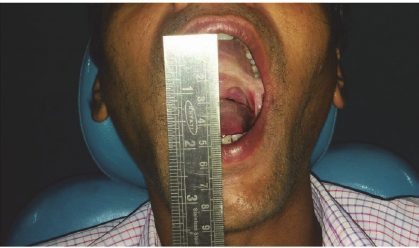
Figure 10: 6-month postoperative passive mouth opening—43